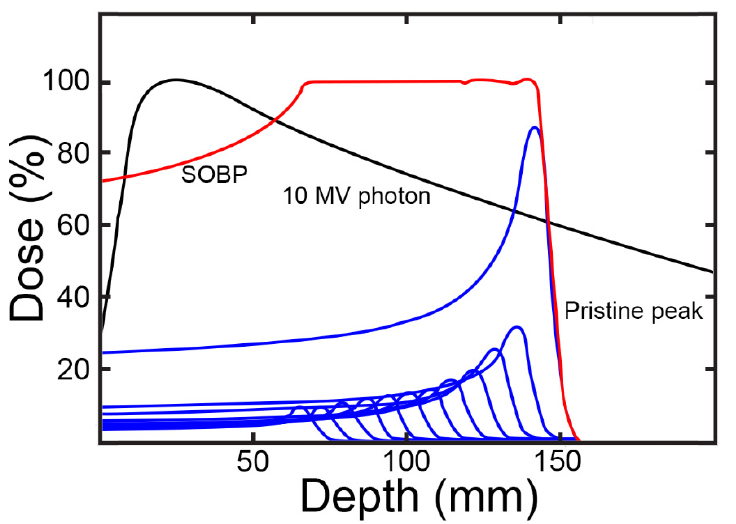
Figure 4. Distribution of dose percentage in respect of penetration depth for a spread-out Bragg peak of a particle beam (red line). The SOBP dose distribution is the result of the convolution of different mono-energetic Bragg peaks (blue lines). The depth–dose distributions of a 10 MV photon beam (black line) is reported for confrontation.